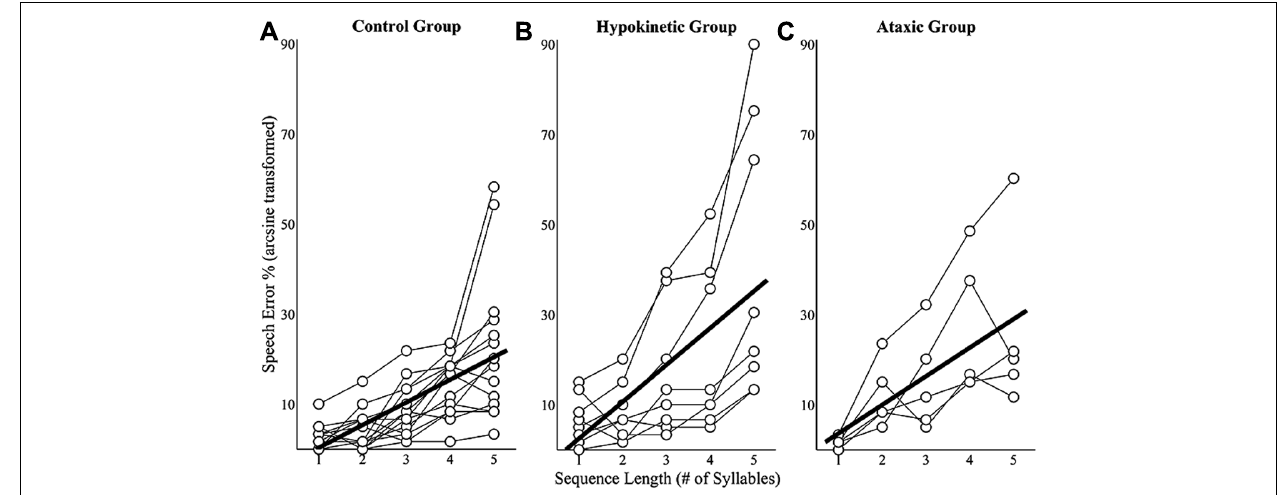
FIGURE 4 | Sequence length effects on speech error rates for the healthy speaker group (A), the hypokinetic speaker group (B), and the ataxic speaker group (C) . Significant effects were observed in the healthy speaker group and hypokinetic group with Parkinson’s disease.The line of best fit is displayed in the plots for these